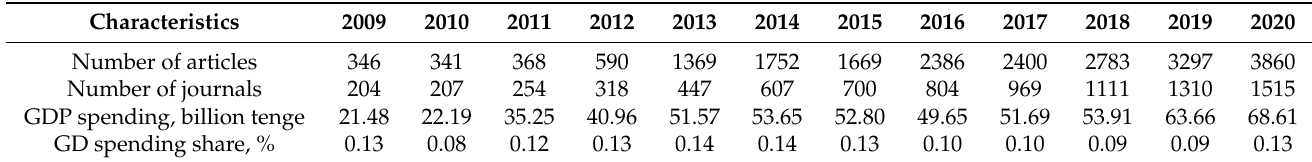
Table 3. The publication output and GDP spending on science in Kazakhstan.